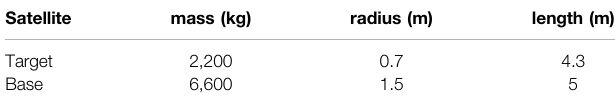
TABLE 2 | Assumed base and target satellite parameters.